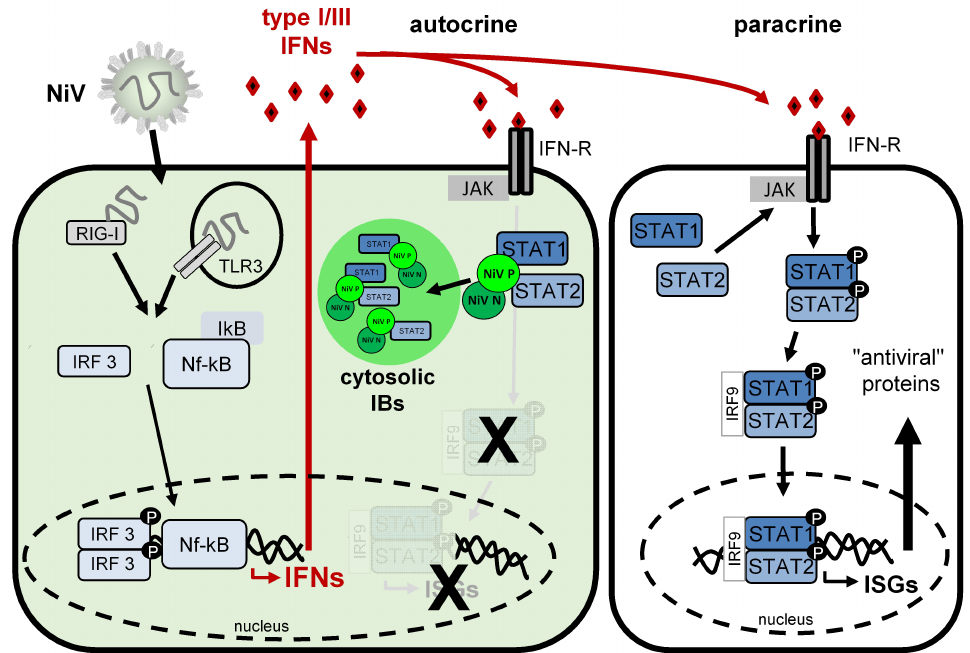
Figure 7. Model illustrating NiV-mediated blockade of autocrine IFN signaling by STAT sequestration to cytosolic IBs. In cells infected with NiV (cell on the left), viral RNA is recognized via cytosolic RIG-I or endosomal TLR3. This leads to the activation of IRF3 and NF- κ B, which migrate to the nucleus and induce the expression of type I and type III IFNs. IFNs are secreted by infected cells and bind to their respective IFN receptors (IFN-R) on the infected cell itself or on non-infected neighboring cells, inducing either autocrine or paracrine IFN signaling. In infected cells (left), viral N and P proteins rapidly form cytosolic IBs into which STAT1 and STAT2 are recruited by the NiV P protein. Because free cytosolic STAT1 and STAT2 is lacking and cannot be phosphorylated by JAK in response to IFN receptor activation, autocrine IFN signaling cannot occur and antiviral ISG expression is prevented in infected cells. In contrast, paracrine IFN signaling is functional. In non-infected cells (cell on the right), cytosolic non-activated STAT1 and STAT2 are recruited and phosphorylated by JAK in response to IFN receptor activation. pSTAT1 and pSTAT2 dimerize and, together with IRF9, translocate to the nucleus to drive the expression of ISGs. Consequently, antiviral proteins are expressed in non-infected